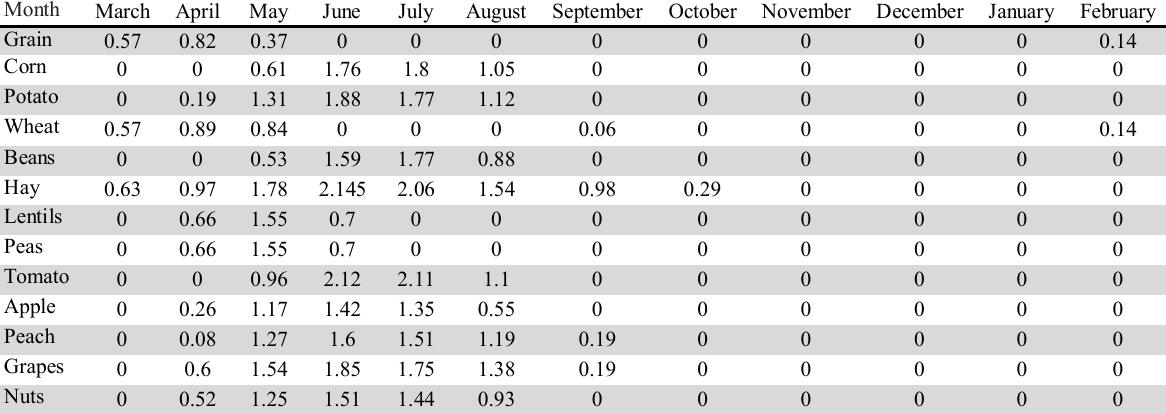
The amount of water flow needed for each product in term of thousand cubic meter per hectare